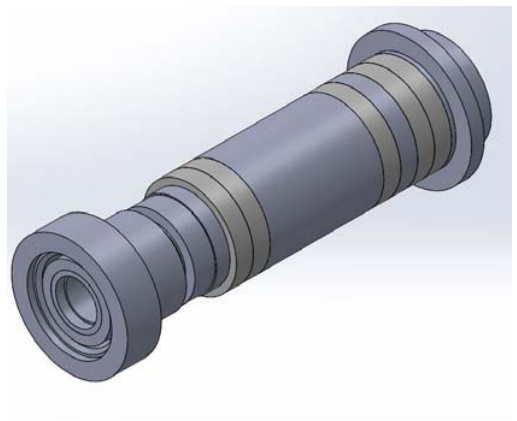
Figure 5. Schematic picture of the Model.